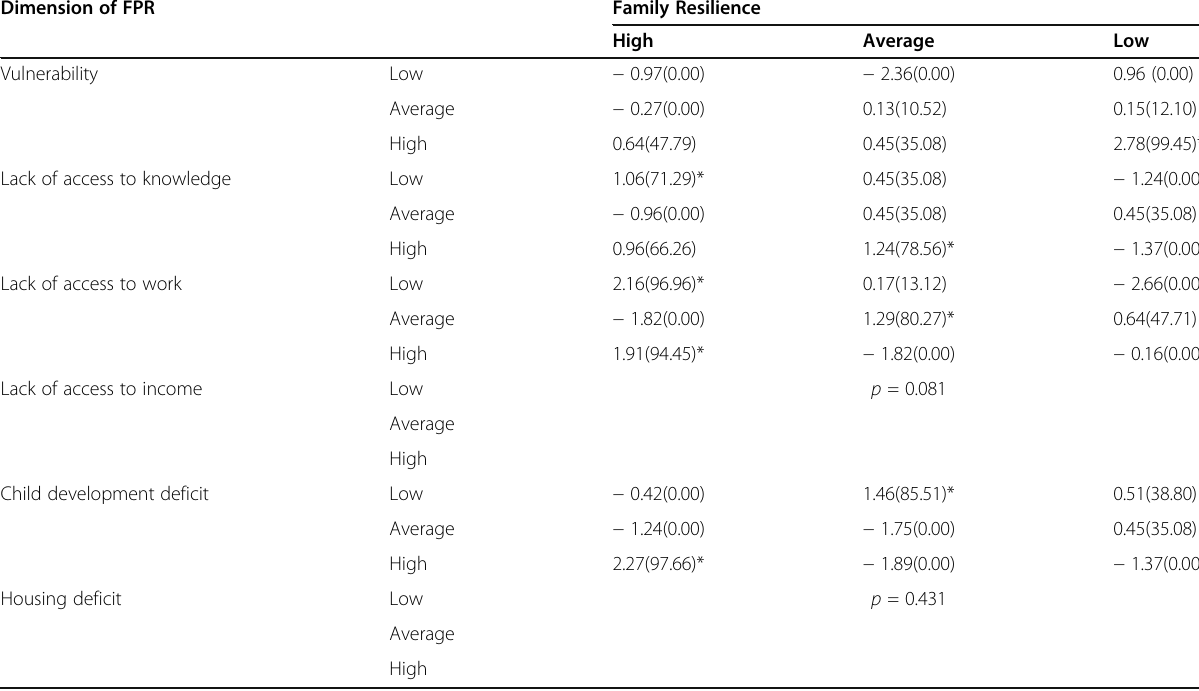
Table 4 Associations between Family Resilience and the dimensions of Family Poverty Rate (FPR) Dimension of